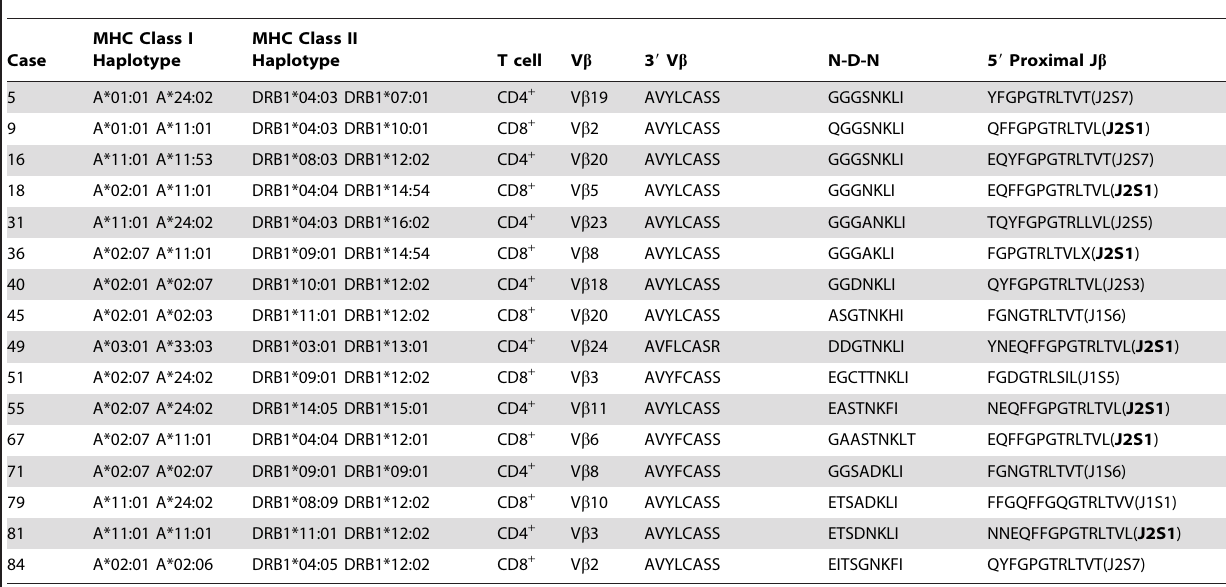
Table 3. Conserved CDR3 sequences from b chain of T cells exhibited a single peak on CDR3 spectratype analysis.